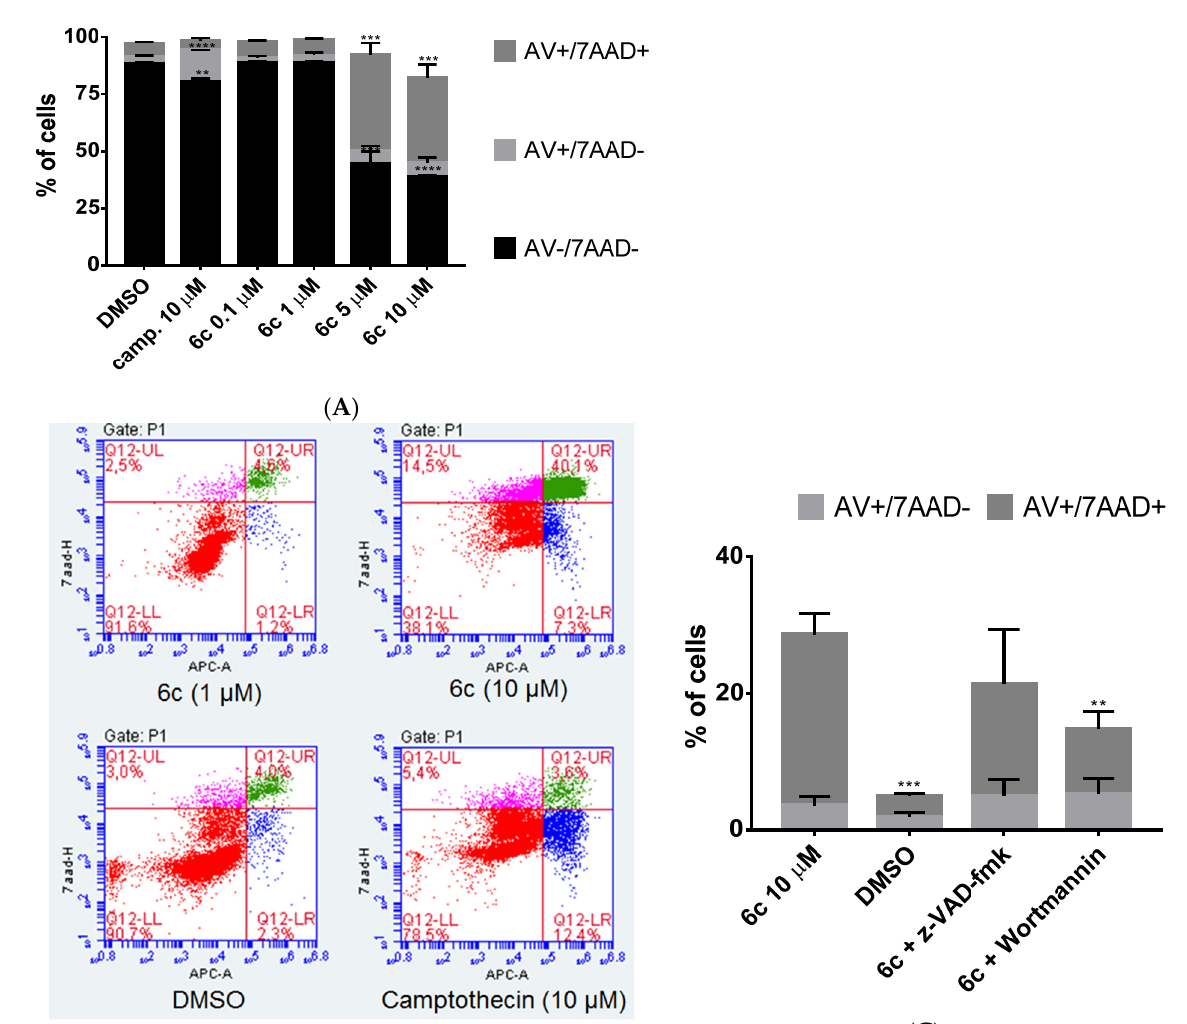
Figure 6. ( A ) Percentage of live cells (AV − /7AAD − ), live cells with loss membrane integrity (AV+/7AAD − ), and dead cells (AV+/7AAD+) after 48 h of treatment at different concentrations in HT ‐ 29 cells. Results are expressed as a mean ± SD of three independent experiments, ** p ≤ 0.01, *** p ≤ 0.001 and **** p ≤ 0.0001 compared to non ‐ treated cells (DMSO). ( B ) Annexin V ‐ APC/7AAD assay of HT ‐ 29 cells treated with 1 and 5 μ M of 6c , vehicle (DMSO), and when treated with 10 μ M of camptothecin (Camp.) after 48 h of treatment. Cell population is represented in different colors: red (AV − /7AAD ‐ ), blue (AV+/7AAD − ), green (AV+/7AAD+), pink (AV − /7AAD+). ( C ) Percentage of AV+/7AAD − and AV+/7AAD+ cells after 24 h of incubation with or without 30 min preincubation with z ‐ VAD ‐ fmk or wortmannin. Results are expressed as a mean ± SD of three independent experiments, ** p ≤ 0.01 and *** p ≤ 0.001 compared to treatment with 6c at 10 μ M.